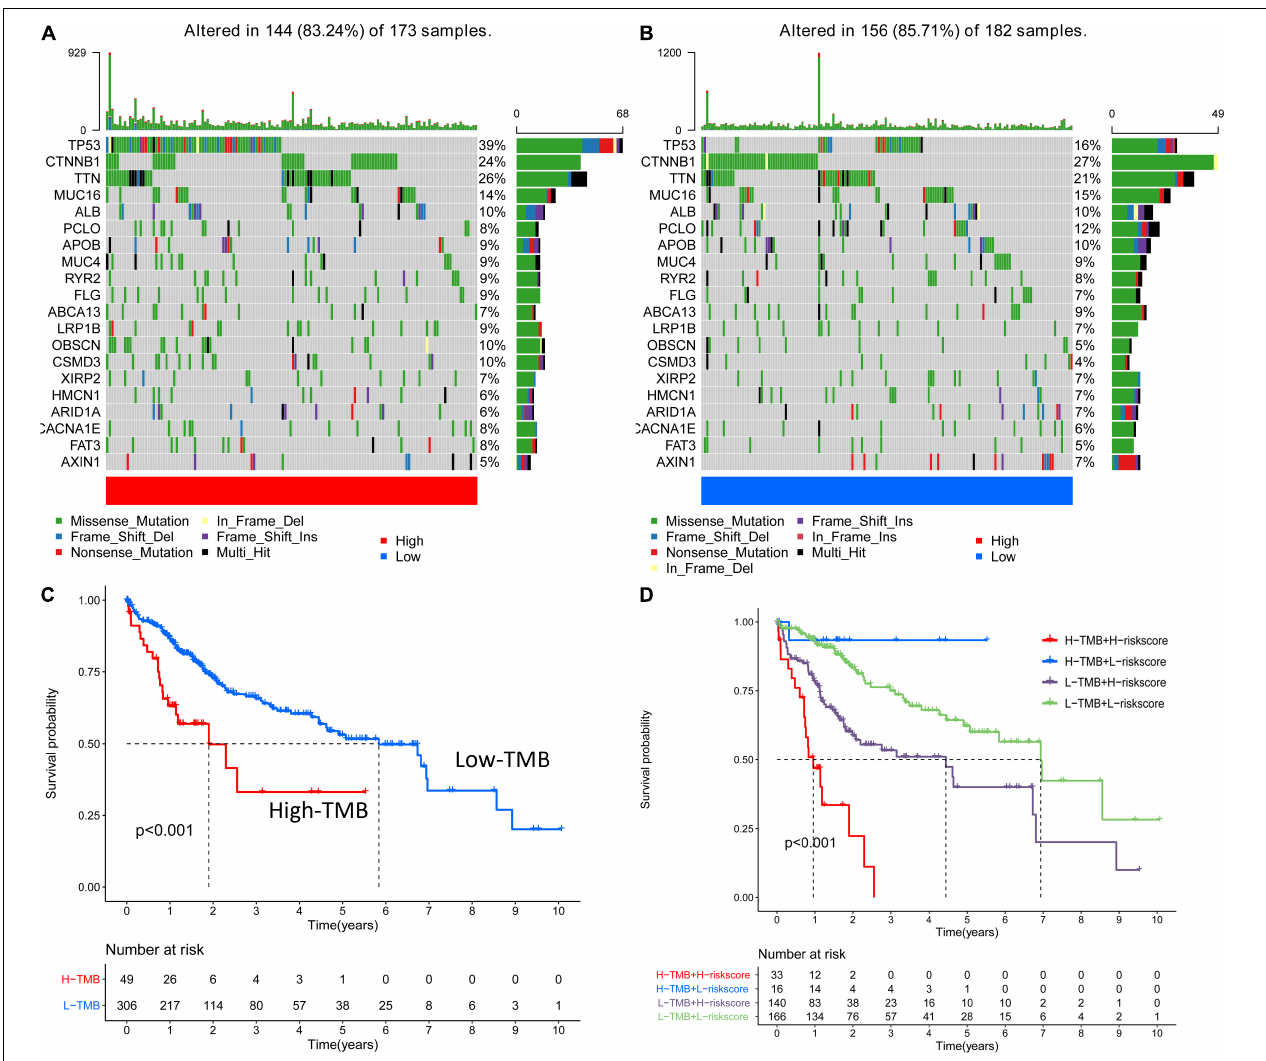
FIGURE 9 | The result of alteration frequency and tumor mutation burden (TMB) between the high- and low-risk group. (A) The top 20 driver genes with the highest alteration in the high-risk group. (B) The top 20 driver genes with the highest alteration in the low-risk group. (C) The connection among the high-/low-score group and TMB, and the results show that the high TMB group demonstrated a poorer prognosis. (D) When high/low TMB is randomly combined with high/low risk, and high TMB is combined with a high risk score indicated a poorer prognosis.